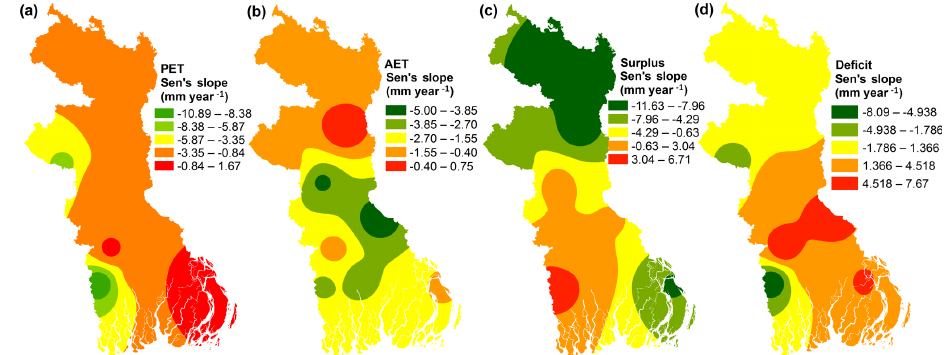
Figure 4. Distribution of rate of changes of WBCs during the period of 1981–1982 to